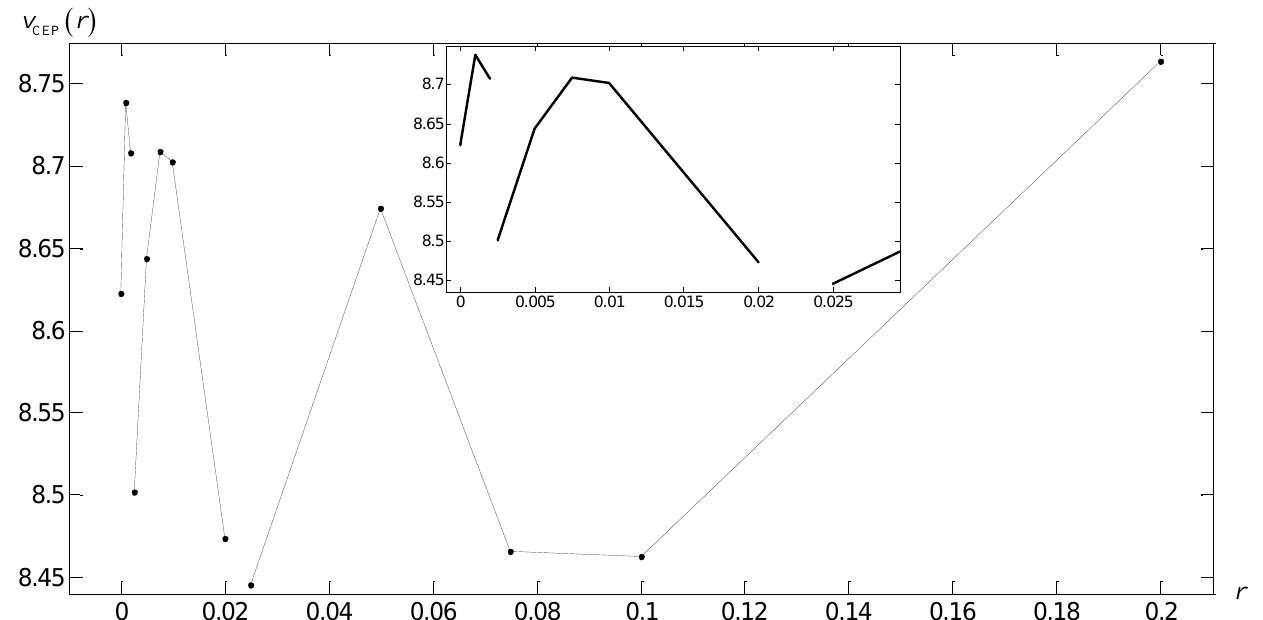
Fig. 2. Additional evaluations of the function   v r on 100 trained 4800-240-26-P by parameters (20) for each of the three sets CEP